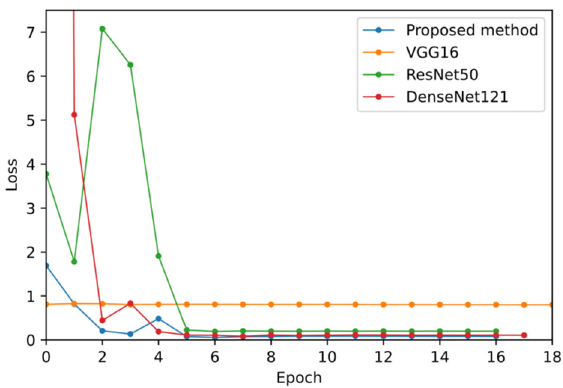
Figure 8. Metrics for validation set on training time for all CNN models.